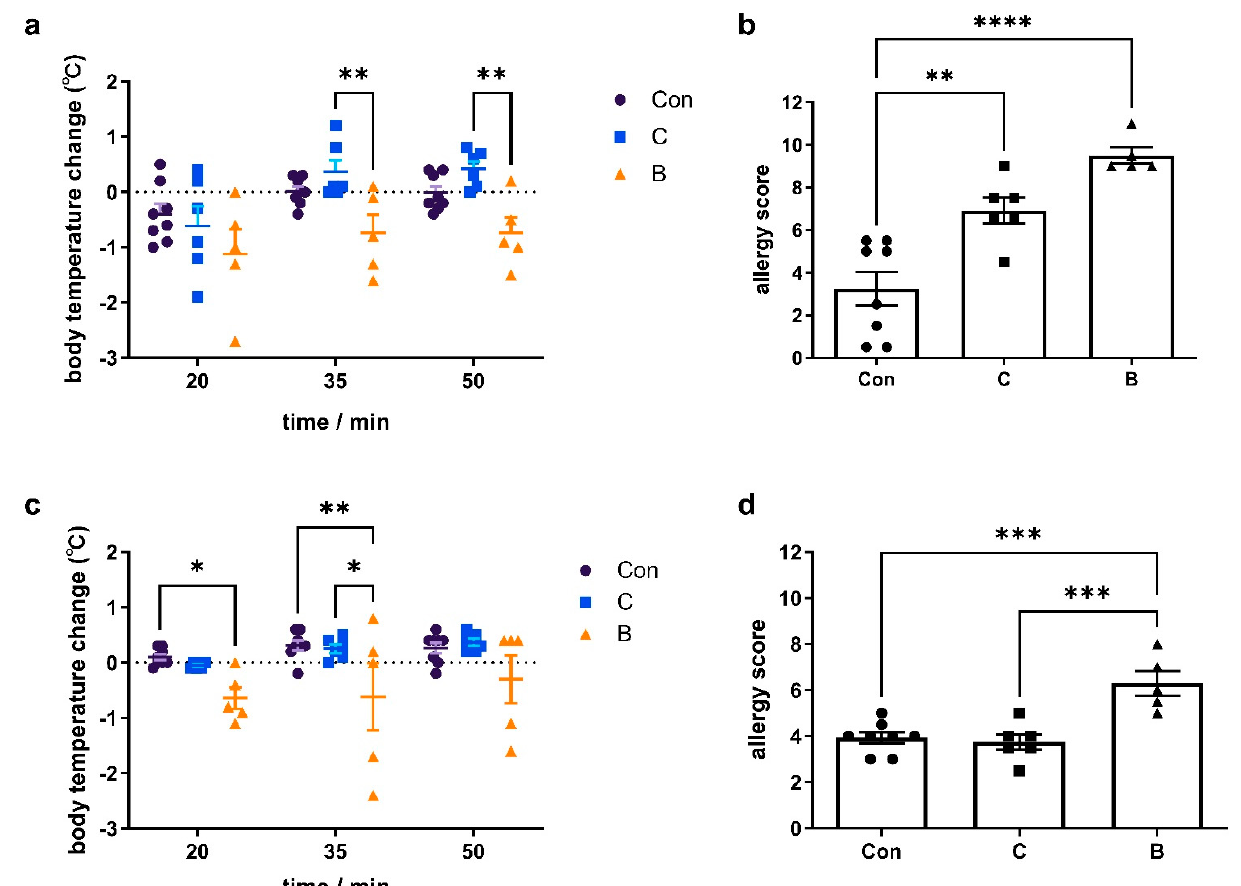
Figure 3. Groups with a 7-day administration of 3% DSS (group B) showed more severe clinical symptoms of FA compared to groups with a long-term administration of DSS (group C). ( a ) body temperature change and ( b ) clinical allergy score after the first oral challenge; ( c ) body temperature change and ( d ) clinical allergy score after the second oral challenge. The change in body temperature was calculated based on the body temperature before the oral challenge. The allergy score was calculated as the sum of the values of the scratching, behavior, physical appearance, and stool consistency. The value was shown as the mean ± SEM for 5–8 animals per group. • represents the individual in group con, ■ represents the individual in group C, ▲ represents the individual in group B, * p < 0.05, ** p < 0.01; *** p < 0.001; **** p < 0.0001.